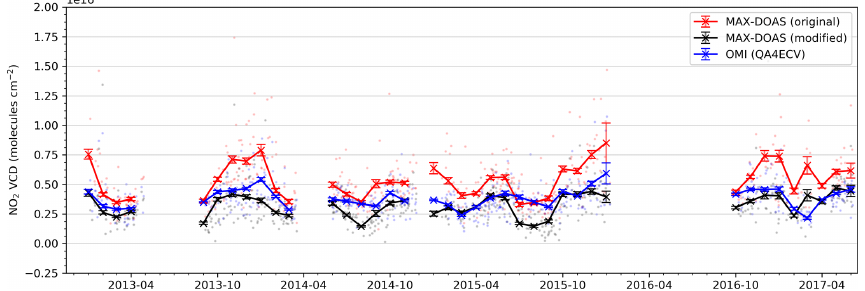
Figure F15. Time series of daily (dots) and monthly means (lines and markers) of MAX-DOAS NO 2 VCDs, OMI QA4ECV NO 2 VCDs, and MAX-DOAS VCDs modified using the QA4ECV averaging kernels and the TM4 a priori profiles.